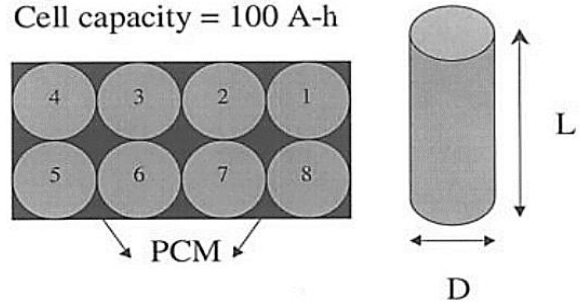
Figure 16. A schematic of the proposed battery module [170].